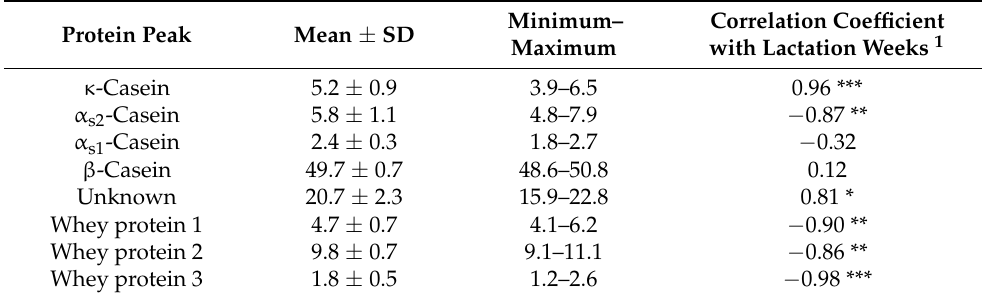
Table 3. Relative protein composition of deer milk (presented as percentages of HPLC peak area of individual proteins in all identified proteins).